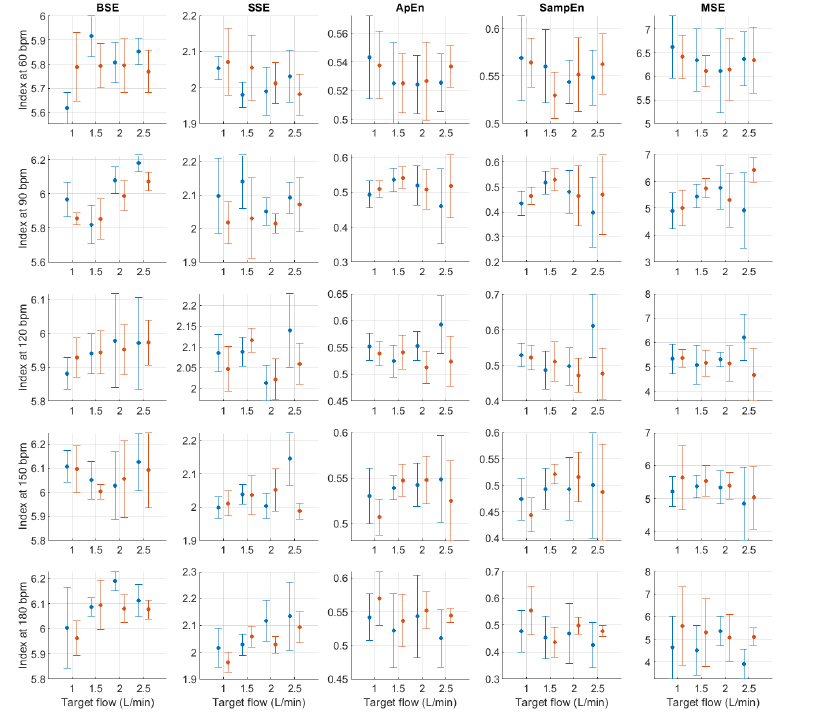
Figure A18. Mean and standard deviation of entropy-related indices extracted from pulse rate variability under different stroke rates (SR) and target flows (TF, TF below 2.5 L/min) conditions, and measured from the radial (blue) and deep palmar arch (orange)